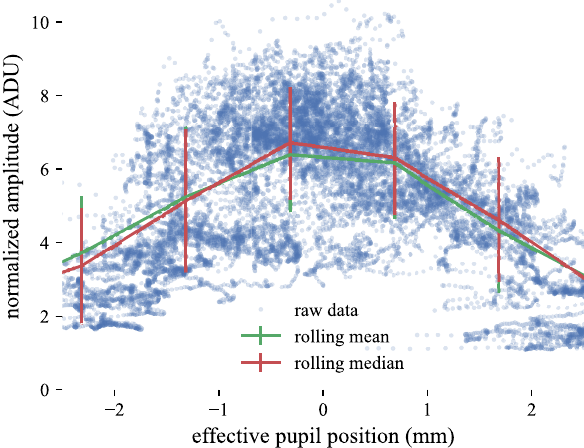
Figure 5. Smoothing IS/OS amplitude. To better visualize the IS/OS reflectance measurements, data were smoothed. In the figure above, the amplitude of the IS/OS from non-drusen retina (subject 2) is plotted as a function of effective pupil position (blue dots). The raw data were smoothed two ways, using a rolling mean (green line) and rolling median (red line). The results of mean- and median-filtering were similar. The standard deviation of the data is illustrated with vertical error bars. An average of 3060 points were used to calculate each median value, and thus the differences in IS/OS amplitude between pupil positions was significant for each 1 mm step. In spite of significant dispersion, a clear relationship can be observed between pupil position and IS/OS amplitude. Sources of dispersion likely include lateral variation in IS/OS reflectivity as well as coherent speckle.